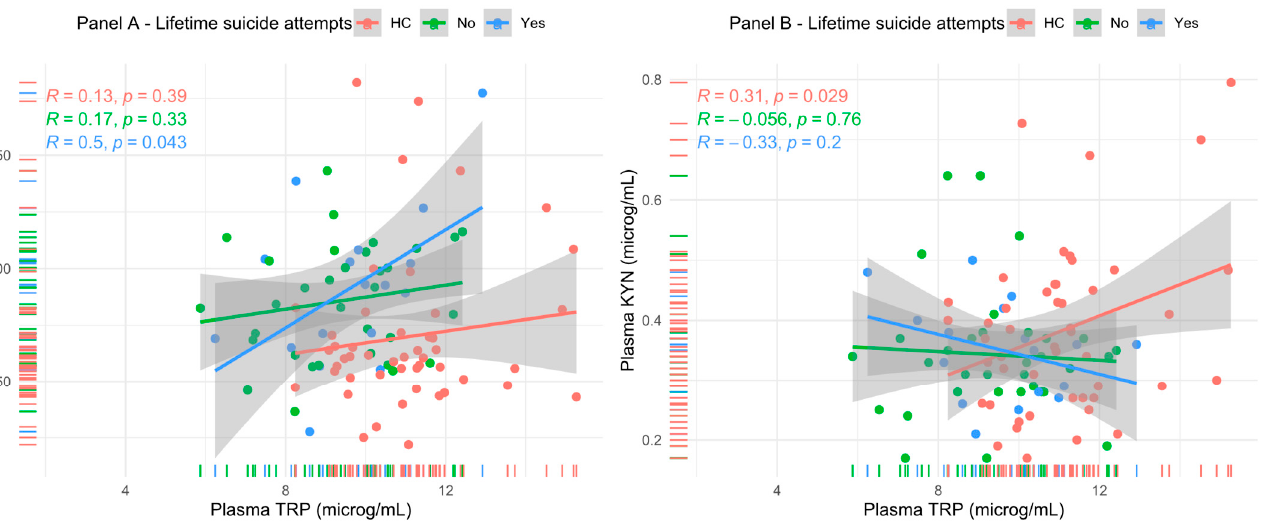
Table 2. Sociodemographic data and psychometric test results for the sample of 45 patients with BD.